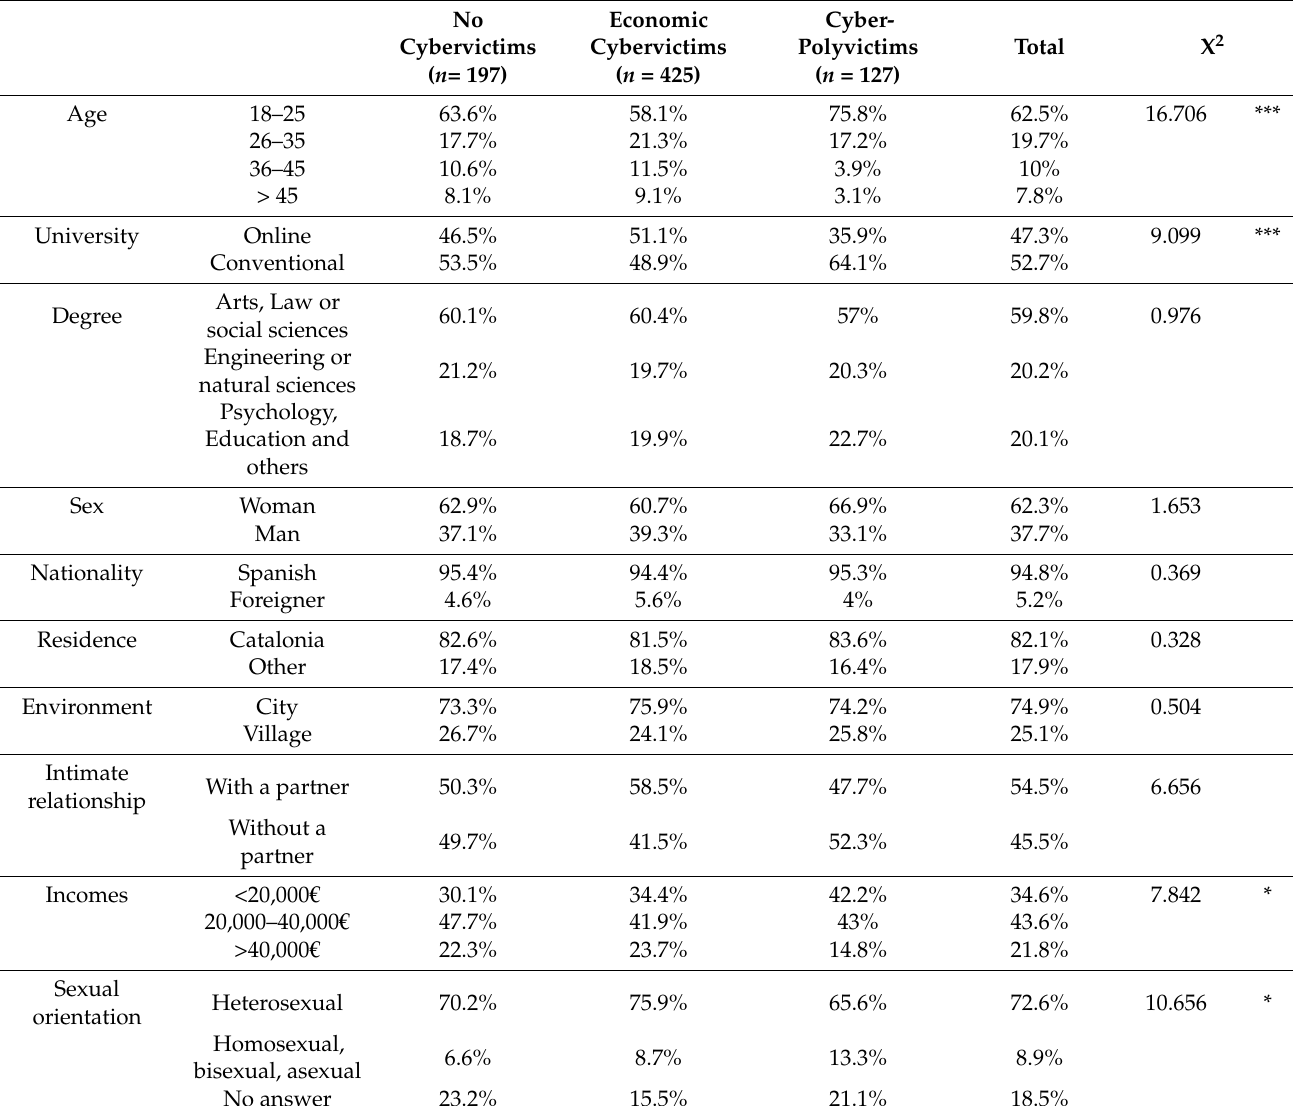
Table 3. Latent classes. Differences of independent variables.